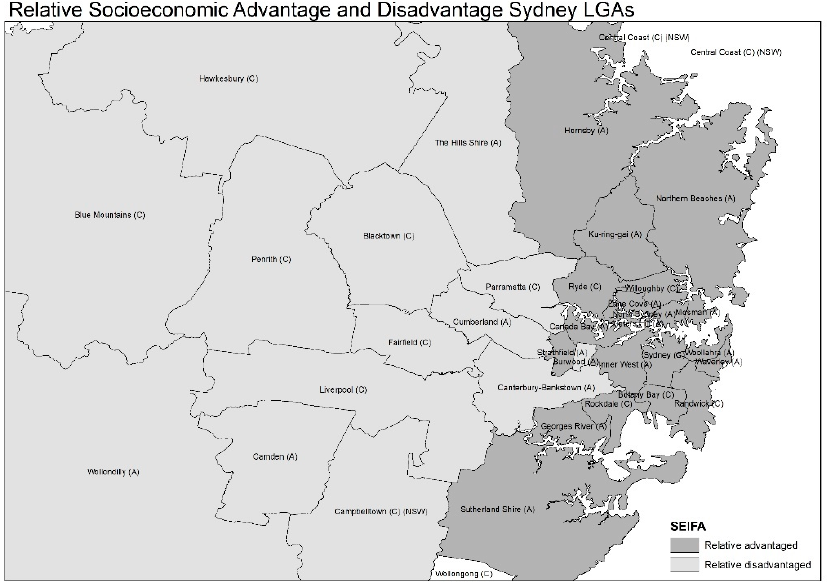
Figure 2. The socio-economic advantage regions in Sydney. Source: authors’ own. Data from the Australian Bureau of Statistics (ABS) Census 2016—SEIFA The Index of Relative Socio-economic Advantage and Disadvantage- IRSAD at Statistical Area Level 2. Local government boundaries are superimposed.